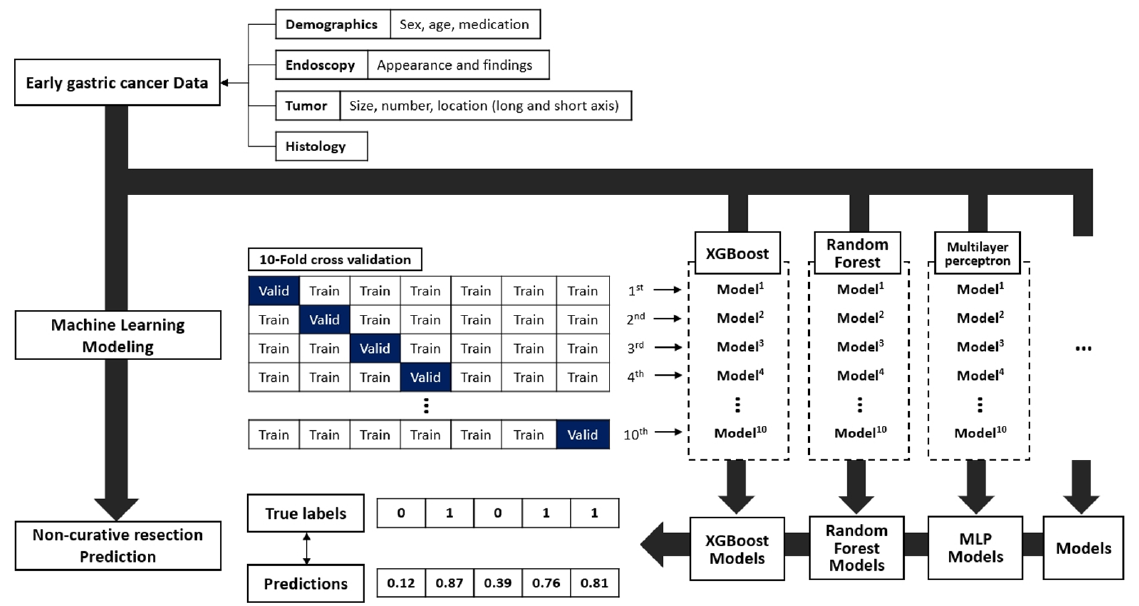
Figure 2. Development of non-curative resection after endoscopic submucosal dissection prediction model.